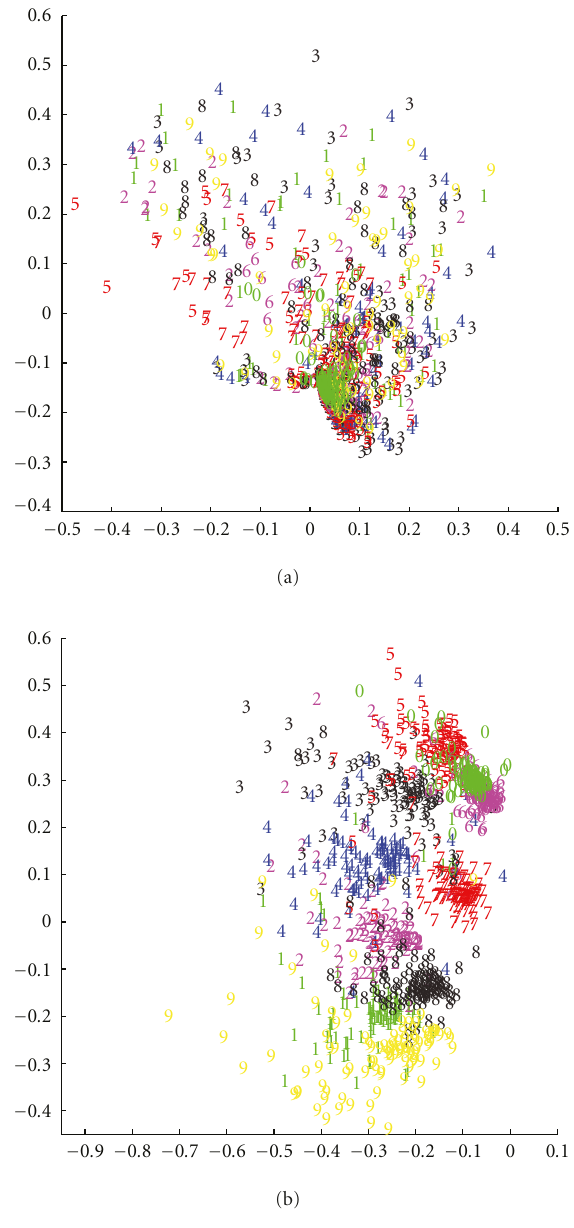
Figure 5: Two dimensional projections of 10 classes in the Extended Yale B database. (a) features calculated by LDA, (b) subject parameters calculated by MDA.